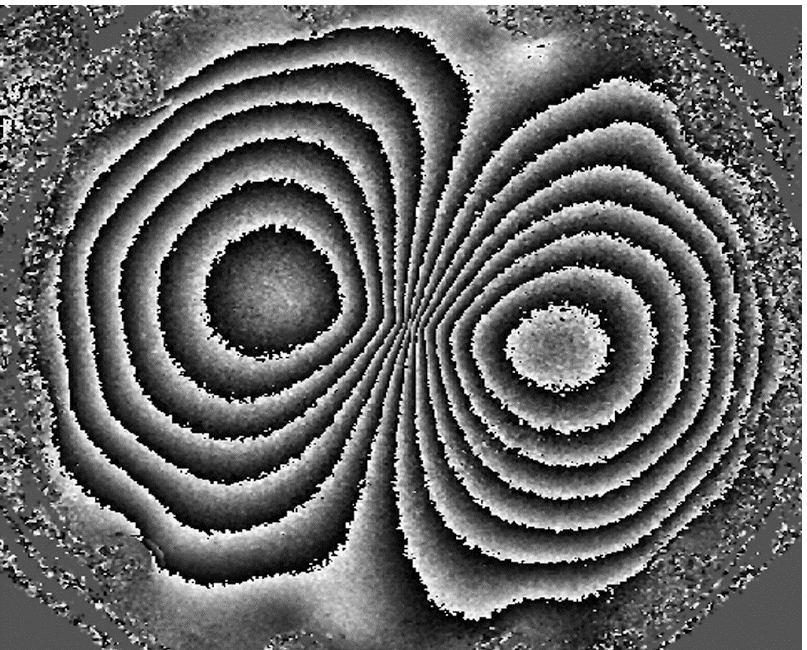
Figure 5. Phase map generated by the 4 + 4 phase stepping algorithm for a 55 µ m central deformation for the Nikon D5300 camera.